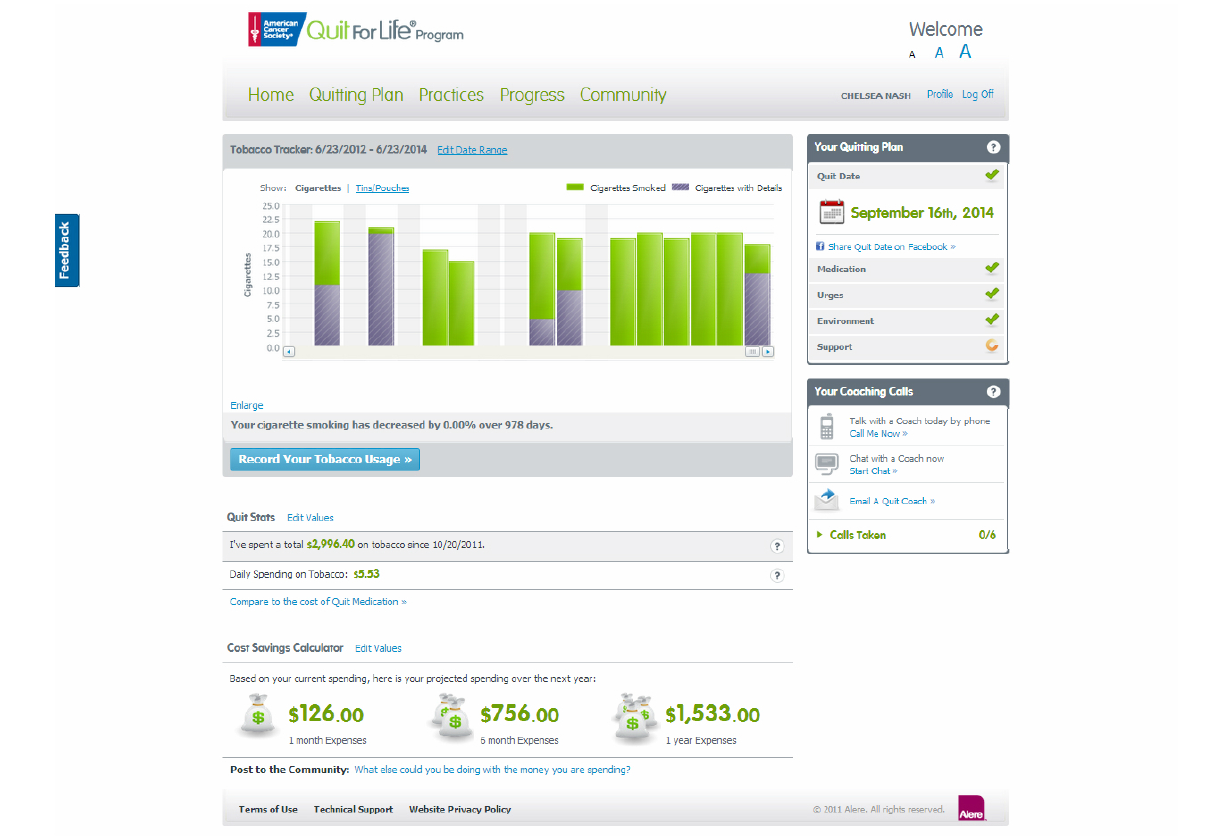
Figure 3. Screenshot of Progress webpage with Tobacco Tracker and Cost Savings Calculator for participants who reported that they were still using